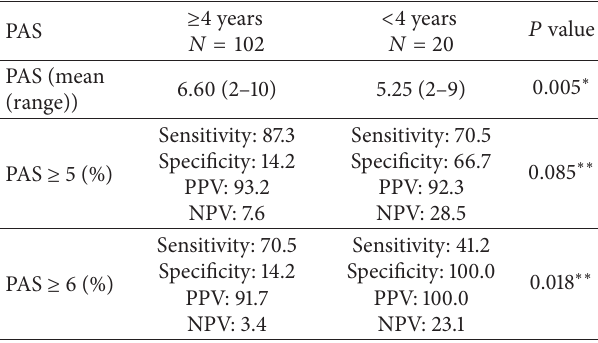
Table 2: Comparison of PAS in older and younger